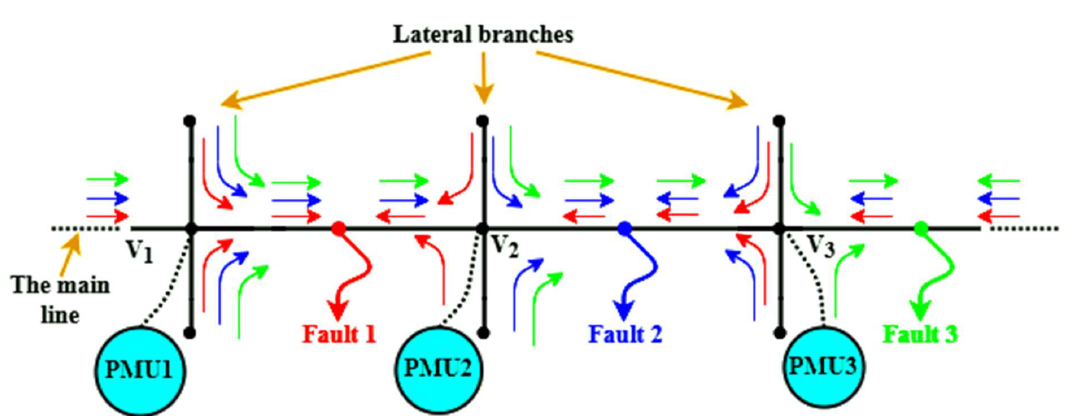
Figure 5. Changes in the direction of line current in exchange for the location of various faults in the main branch of the network.